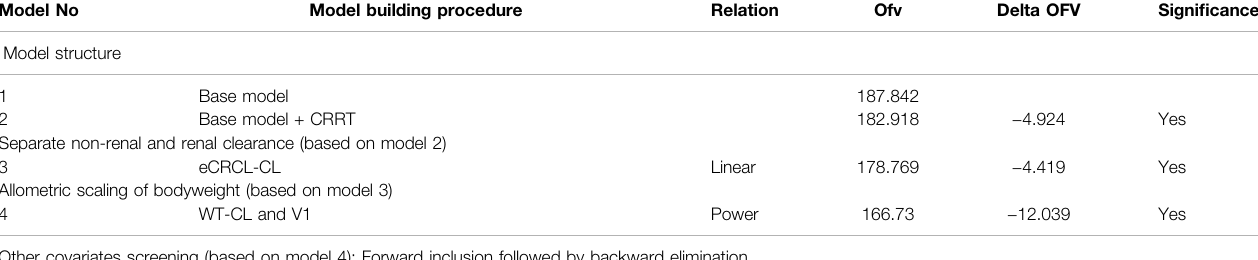
TABLE 3 | The model building and covariates screening